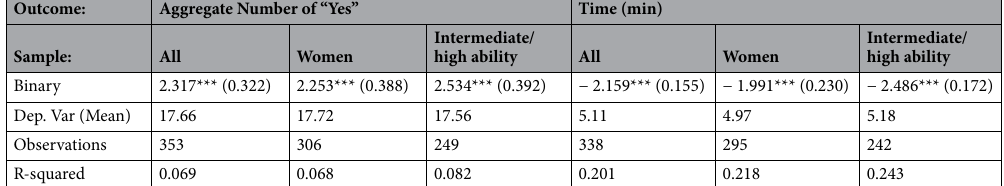
Table 1. Binary vs. continuous set of responses (aggregate level). The dependent variable Aggregate Number of “Yes” responses is the number of “Yes” responses by a subject in the questionnaire. The dependent variable Time, is the duration of the questionnaire (in min). The table reports the estimated coefficients for a dummy variable equal to one if the set of responses is binary. Note that the number of observations is lower when the dependent variable is time because in some cases we have no information on the duration of the survey. Robust standard error in parenthesis. Standard errors clustered at the school level. ***p < 0.01, **p < 0.05, *p < 0.1